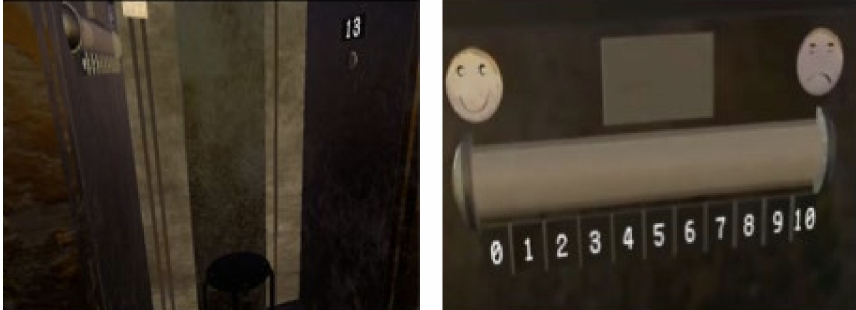
Figure 4. Screenshot of the elevator in the virtual environment (image on the left), including a stool at the bottom of the elevator, the SUD scale on the wall on the left of the image and a button to go to the upper floors on the wall on the right of the image. The detail of the gauge, representing the SUD score from 0 to 10, is on the right of the image.